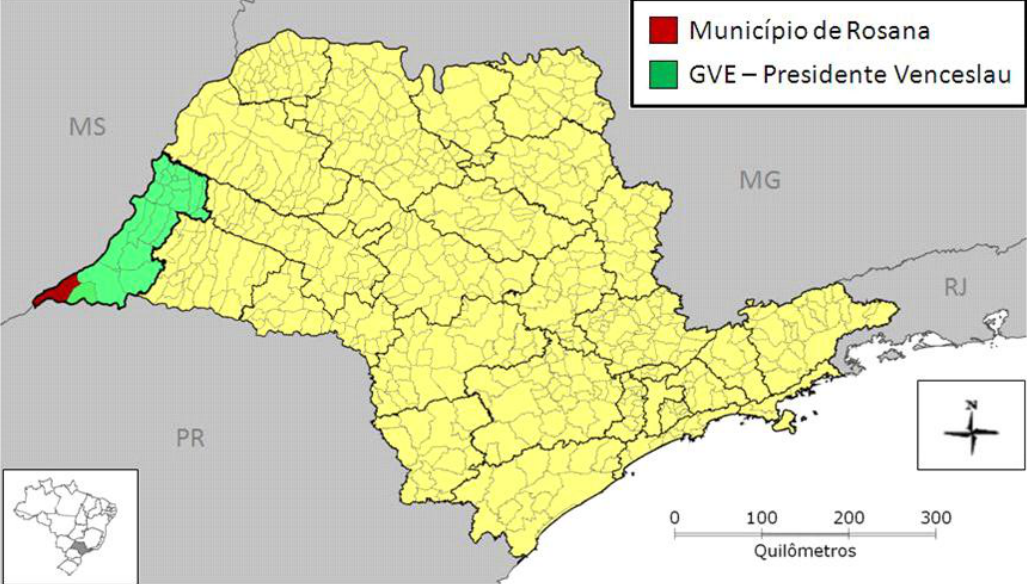
Figure 13. Location of mercury contamination, Municipality of